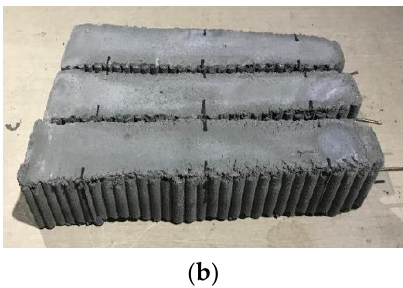
( d ) Figure 10. Compressive strength tests with different loading directions. ( a ) Monolithic specimen; ( b ) Loading direction I; ( c ) Loading direction II; ( d ) Loading direction III. To estimate the splitting tensile strength of concrete, cylindrical or cubic specimens can be used. Cylindrical specimens are recommended in ASTM C 496/C 496M–04 [36], while cubic specimens or cylindrical specimens are recommended in BS EN 12390-6: 2009 [37] and ISO 1920-4: 2020 [38]. For these tests, two lines along which the load is to be ap-